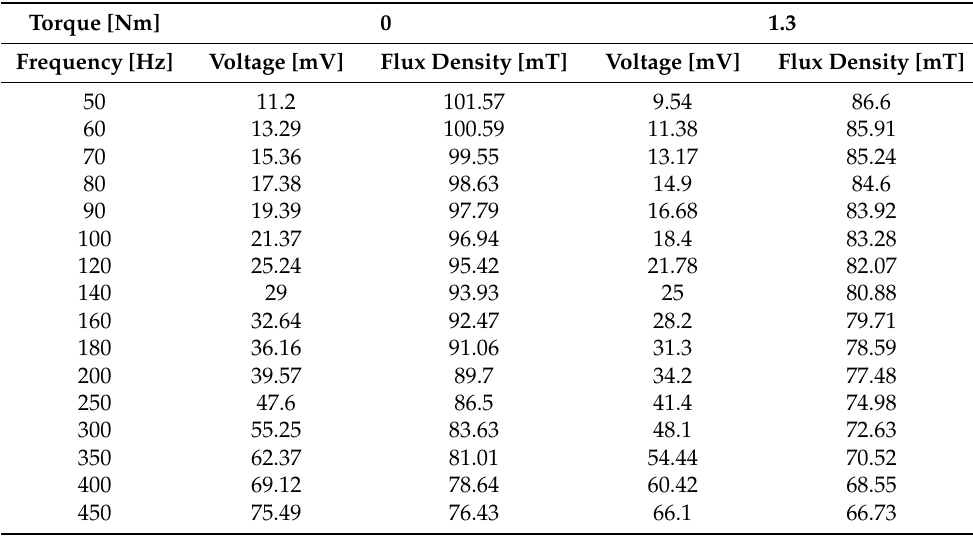
Figure 8. Frequency dependence of sensitivity of magnetoelastic torque sensing system: ( a ) sensitivity characteristics of the FEM model, ( b ) experimentally obtained sensitivity of the real system with 7250R shaft. Table 1. Experimentally obtained frequency dependence of flux density and output voltage with 7250R